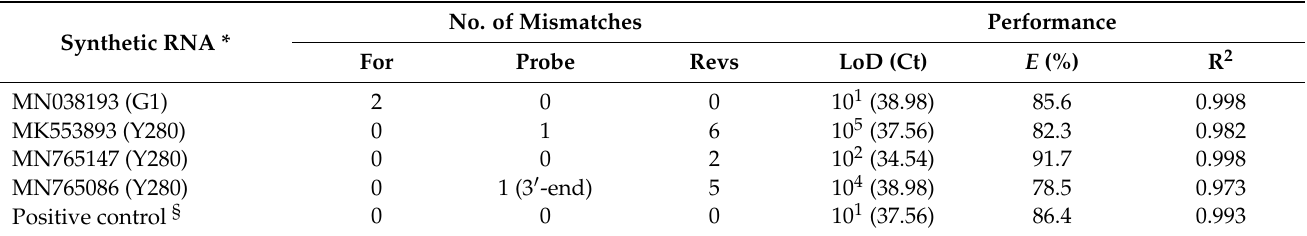
Table 4. Analytical sensitivity of synthetic RNAs representing G1 and Y280 viruses. The LoD is expressed as copies/ µ L of RNA and mean Ct values. For each dilution series, the amplification efficiency E (%) and the coefficient of correlation R 2 are